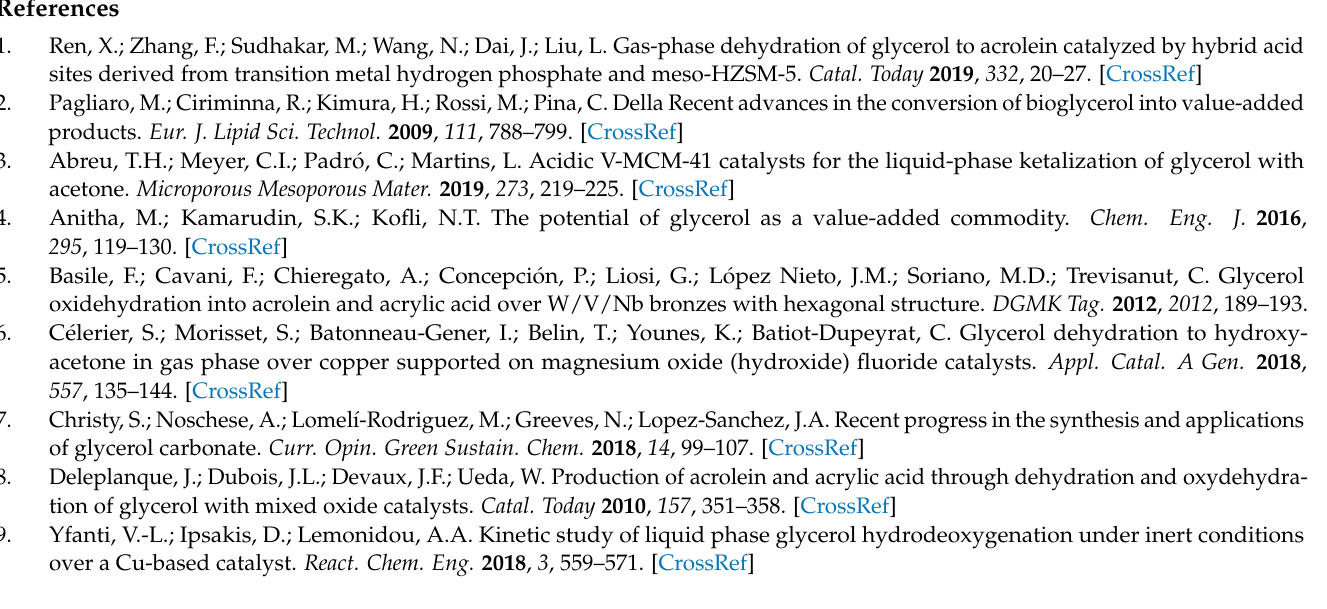
and used catalysts. (Table S1: Elemental analysis of fresh and used samples; Figure S1: XRD analysis of MOF(HKUST-1)-Zr(C) and Cu(M)-Zr(C) samples; FigureS2: SEMmicrographofMOF(HKUST-1)-Zr(C) (left panel) and its corresponding O, Zn, Cu combined EDS map (right panel); Figure S3: SEM micro- graph of Cu(M)-Zr(C) (left panel) and its corresponding O, Zn, Cu combined EDS map (right panel); Figure S4: TG in air environment on MOF(HKUST-1), MOF(HKUST-1)-Zr(C), and Cu(M)-Zr(C) samples), Section S2: Fluid dynamics and mass transfer calculations. (Table S2: values used for calculations; Table S3: results of